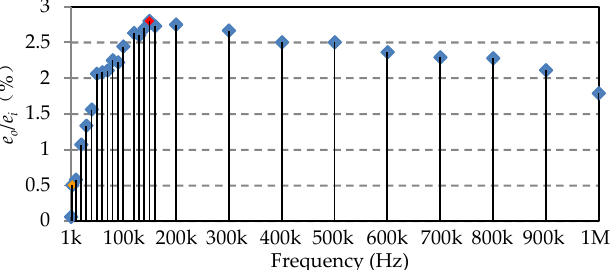
Figure 11. Frequency response of the sensor prototype. The plot is obtained by sweeping the frequency of the driving EMF ( e i ) to the primary coil and recording the induced EMF ( e o ) in the secondary coil.